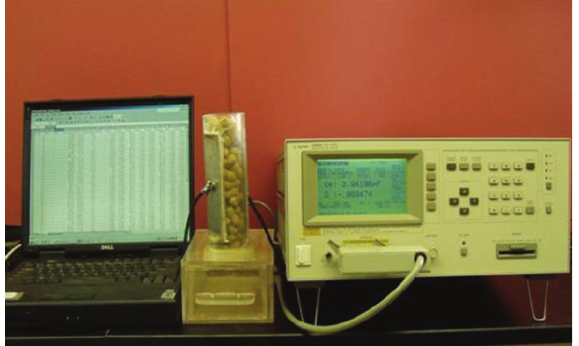
Figure 1: Experimental set up of RF signal measuring